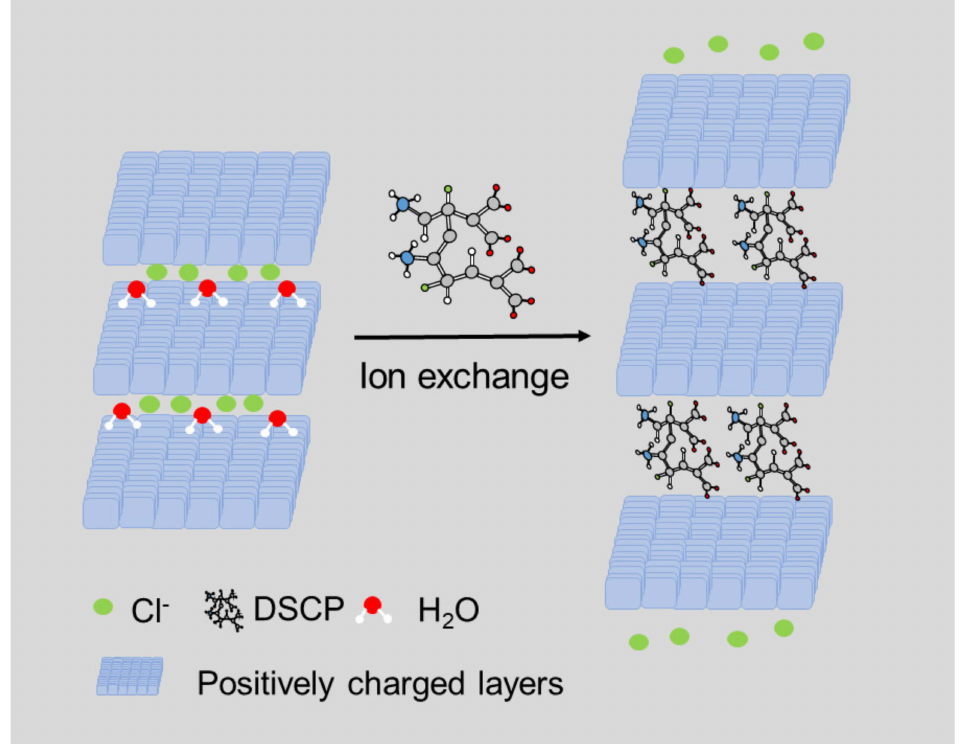
Figure 4. Schematic illustration of loading the cisplatin prodrug, disuccinatocisplatin (DSCP), into Layered Double Hydroxides through ion exchange (adapted from Ma, R., et al. Journal of Materials Chemistry B , 2014